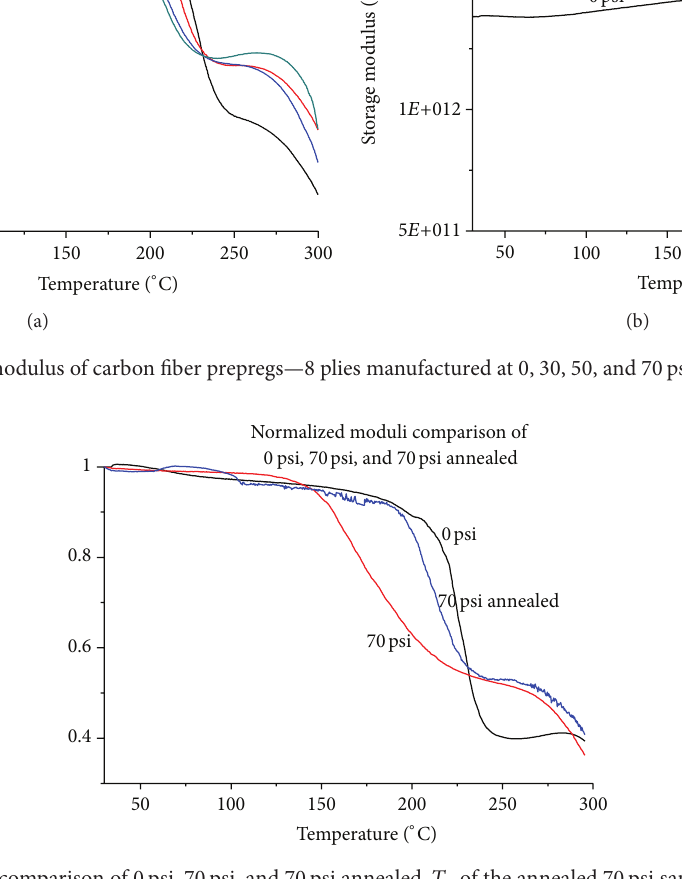
Figure 12: Normalized moduli comparison of 0 psi, 70 psi, and 70psi annealed. 𝑇 𝑔 of the annealed 70 psi sample at 220 ∘ C is much closer to the 0 psi sample 𝑇 𝑔 .